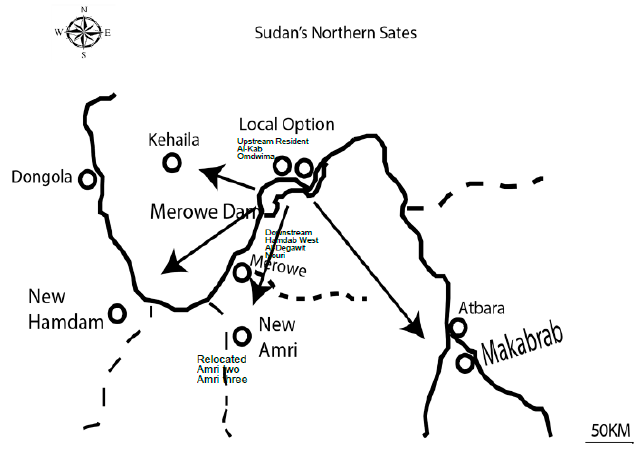
Figure 2. The Location of the study upstream and downstream. Source: Author.